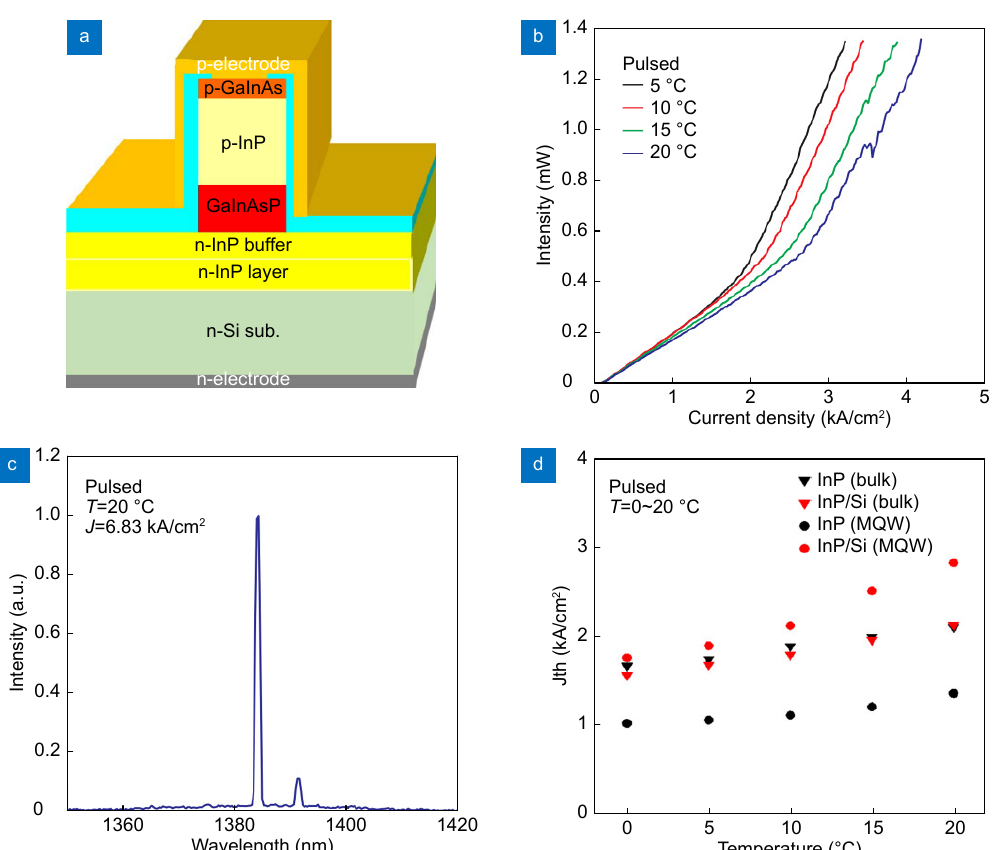
Fig. 13 | ( a ) A typical laser structure. ( b ) The typical I-L characteristics of the MQW laser on the bonded substrate at various temperatures. ( c ) A lasing spectrum for the MQW laser at an input current of J =6.83 kA/cm 2 . ( d ) The temperature dependence of the threshold current density for the DH bulk lasers and MQW lasers on bonded substrates and on native substraes. Figure repoduced with permisson from: (a) ref. 26 , IEEE; (b, c, d) ref. 27 ,